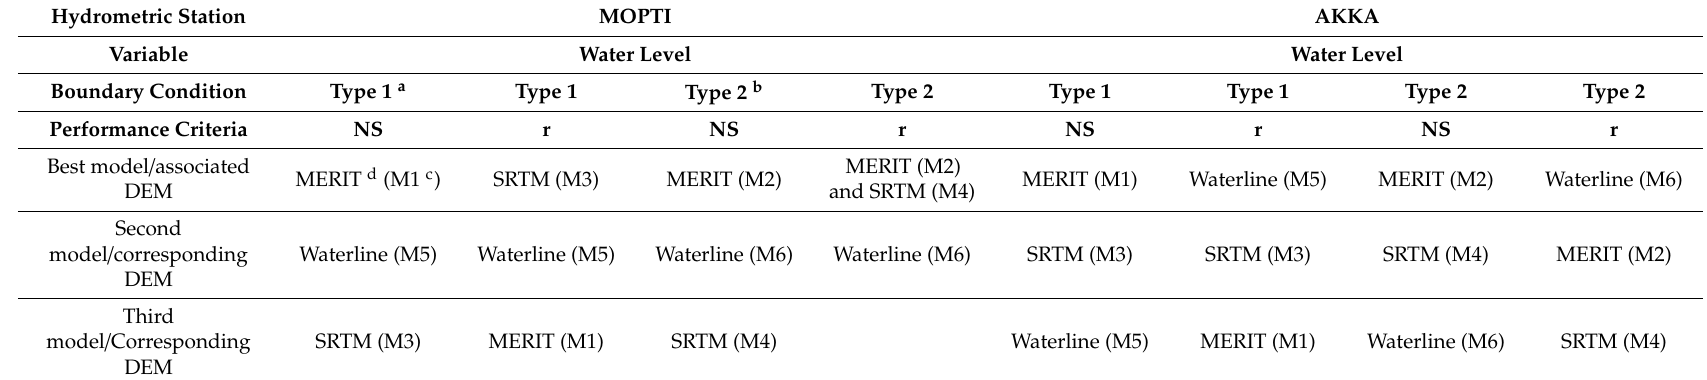
Table 8. Model ranking based on performance (NS and r) for water level at Mopti and